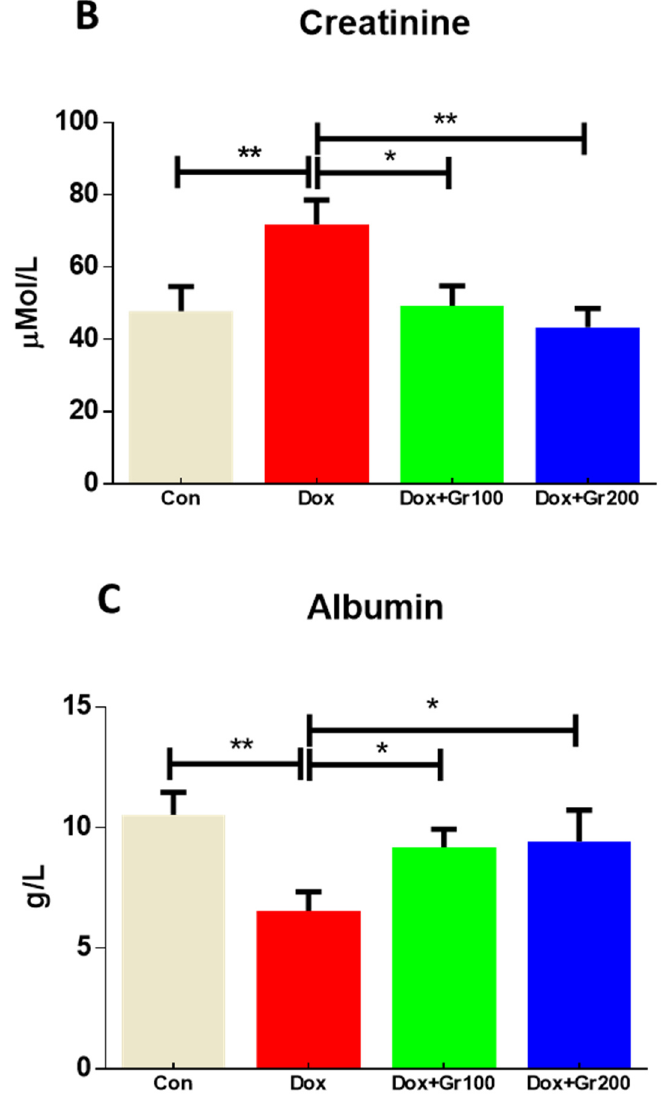
Figure 1. ( A – C ) Effects of geraniol (Gr), doxorubicin (Dox), or their combination (Dox + Gr100 and Dox + Gr200) on kidney function markers. Data are presented as mean + SD (n = 5). *, p < 0.05; **, p < 0.01; Gr100 and Gr200 indicate 100 and 200 mg of geraniol per kilogram of body weight, respec- tively.